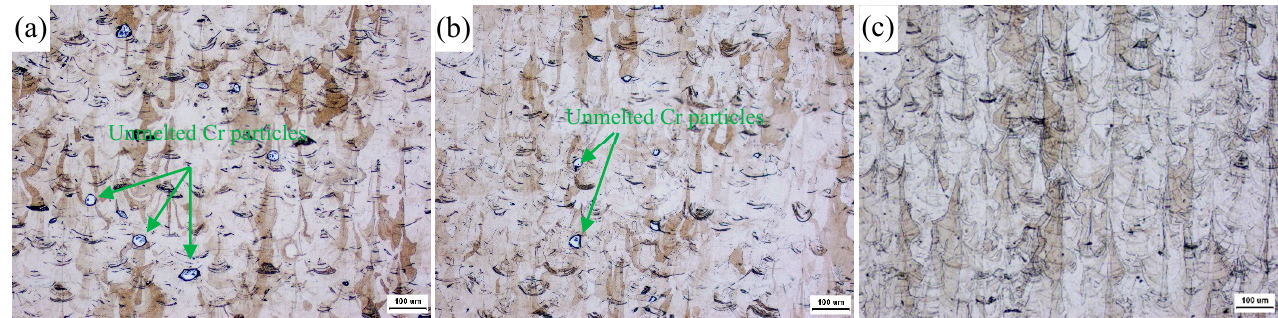
Figure 2. Optical micrographs of the XZ plane (parallel to the building direction) of as-built samples; ( a ) the sample under the P1 process, ( b ) the sample under the P2 process, ( c ) the sample under the P3 process.